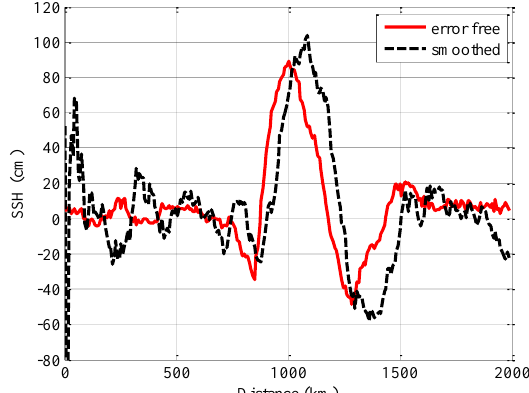
Figure 5. Linear Kalman filter based Tsunami lead wave reconstruction